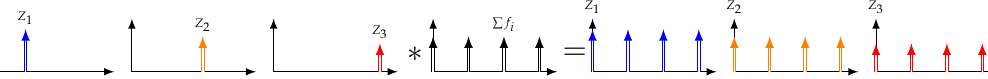
Figure 3. Conceptual representation of impedance spectroscopy based on single-frequency excitation and coherent sampling in frequency domain.